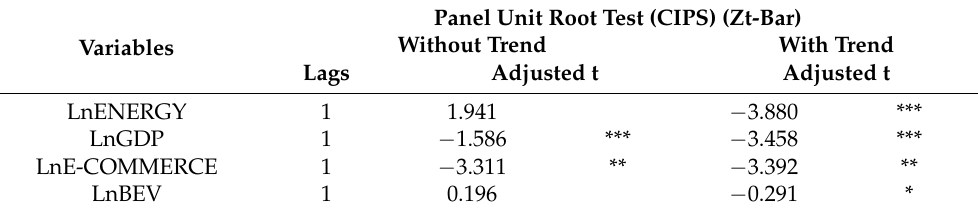
Table 7. Unit Root test.